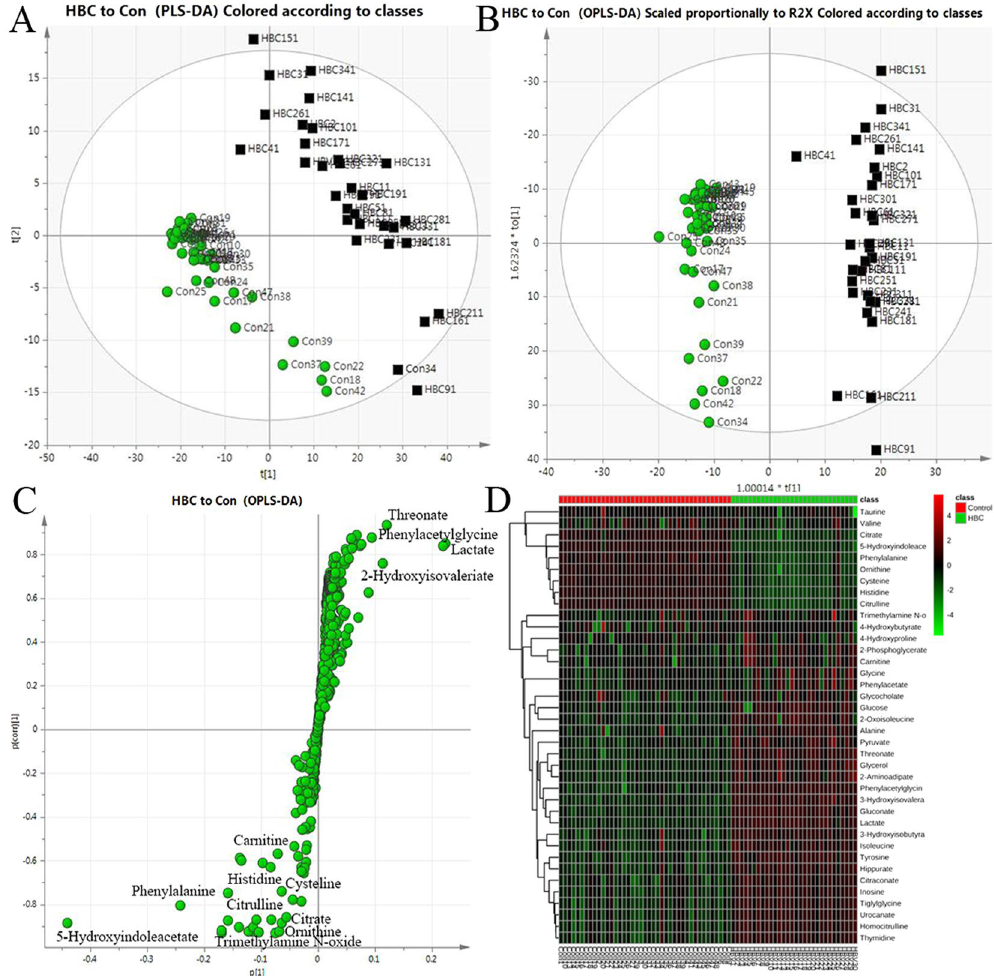
Figure 4. The serum PCA score plot ( A ), OPLS-DA ( B ), S-plot ( C ) and heat map ( D ) used to distinguish between the HBC patients and healthy control groups. A total of 40 metabolites were identified that could distinguish between the HBC patients and healthy